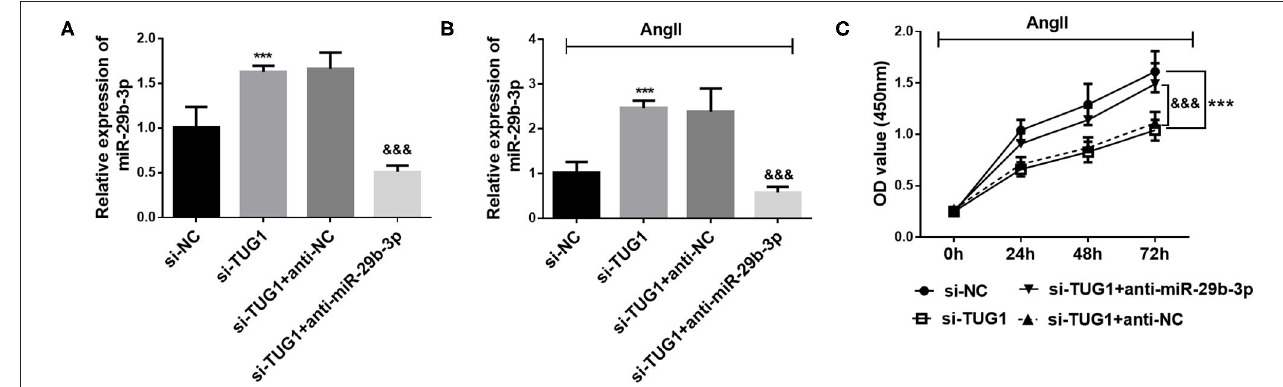
FIGURE 4 | Downregulation of miR-29b-3p reversed the role of TUG1 in CF proliferation. (A) miR-29b-3p inhibitor transfection significantly reduced the level of miR-29b-3p in CFs (*** p < 0.001). (B) miR-29b-3p downregulation significantly reversed the upregulation of miR-29b-3p induced by TUG1 knockdown (*** p < 0.001, compared with the si-NC group; &&& p < 0.001, compared with the si-TUG1 group). (C) Downregulation of miR-29b-3p reversed the inhibiting effect of TUG1 knockdown against CF proliferation (*** p < 0.001, compared with the si-NC group; &&& p < 0.001, compared with the si-TUG1